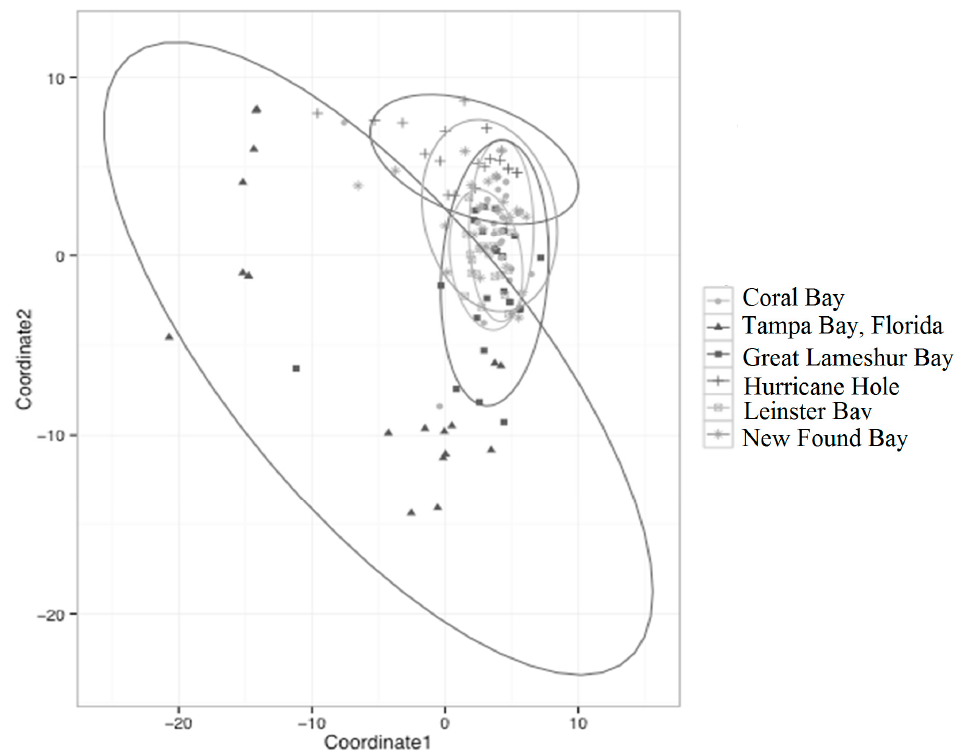
Figure 3. Principal coordinate analysis of the 139 mangrove trees examined in this study. 2D PCoA employing genetic distances derived from microsatellite